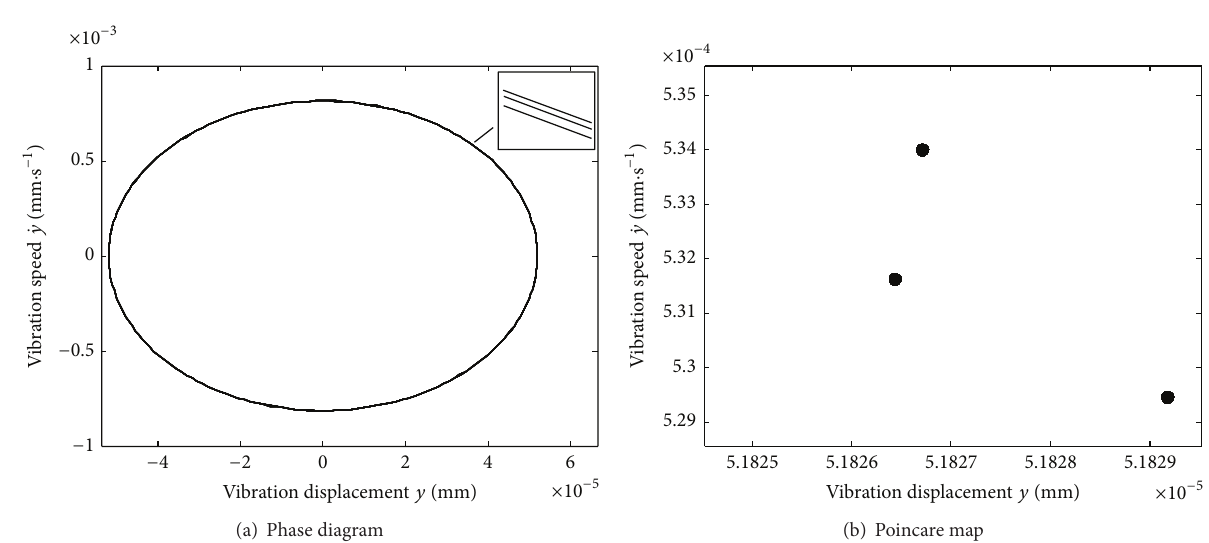
Figure 12: Period-3 motion when 𝜎 = 50 Hz and 𝜀𝐹 = 1.06